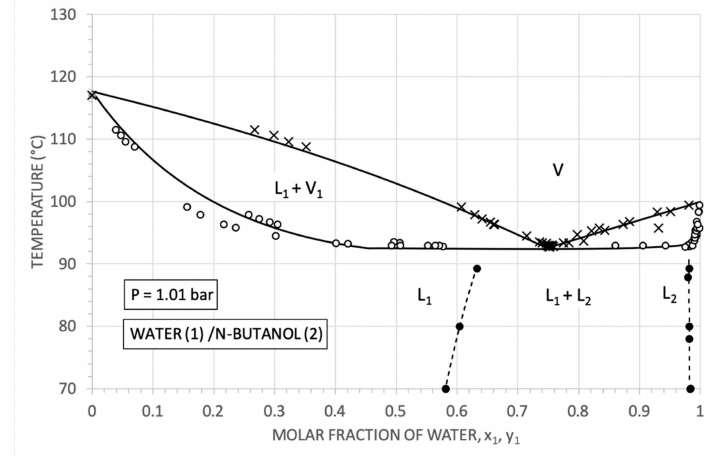
Figure 2. Isobaric VLE diagram for water / n-butanol mixture at 1 bar. Experimental values (dots and crosses, from Aspen Plus © (v 9.0)) and calculated results (solid line). Letters “V” and “L” identify vapour and liquid phases,